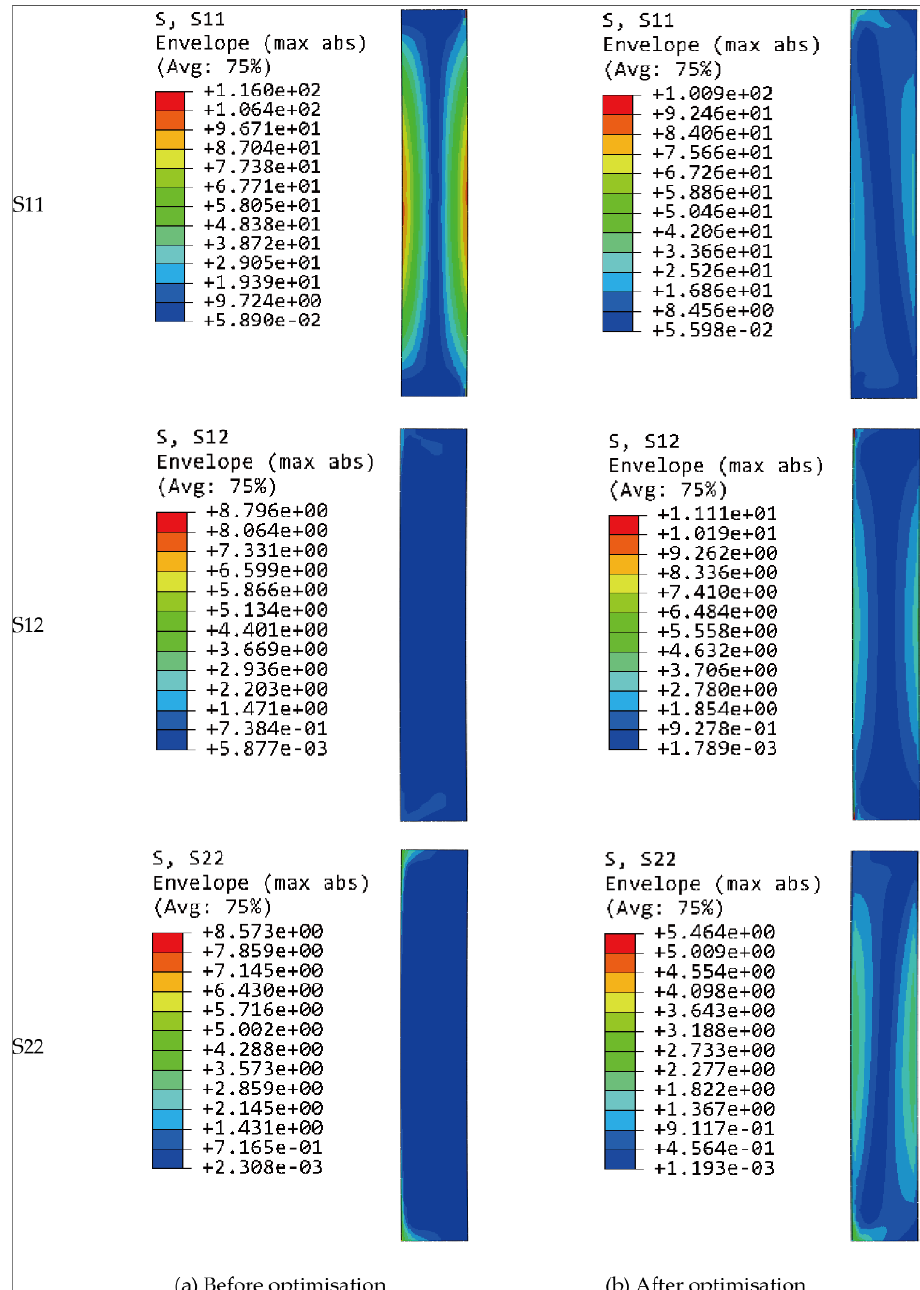
Figure 11. Stress contour of the laminate before and after optimisation: ( a ) Stress contour before optimisation; ( b ) Stress contour after optimisation.